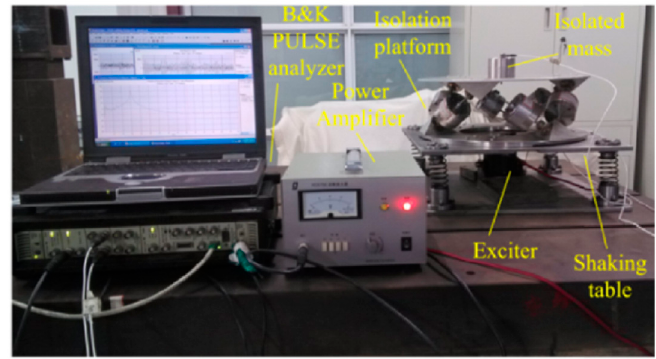
Figure 10. Schematic diagram of the first proposed negative-stiffness magnetic spring (NSMS) vibration isolator: ( a ) Geometric parameters of the first NSMS vibration isolator and ( b ) distribution of equivalent current on the first proposed NSMS vibration isolator [60].